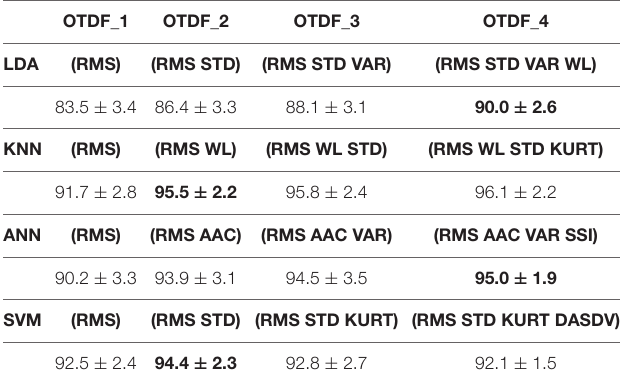
TABLE 2 | Classification performance (averaged CA ± SD %) for the optimal time domain feature (OTDF) combinations with the number of features from 1 to 4.